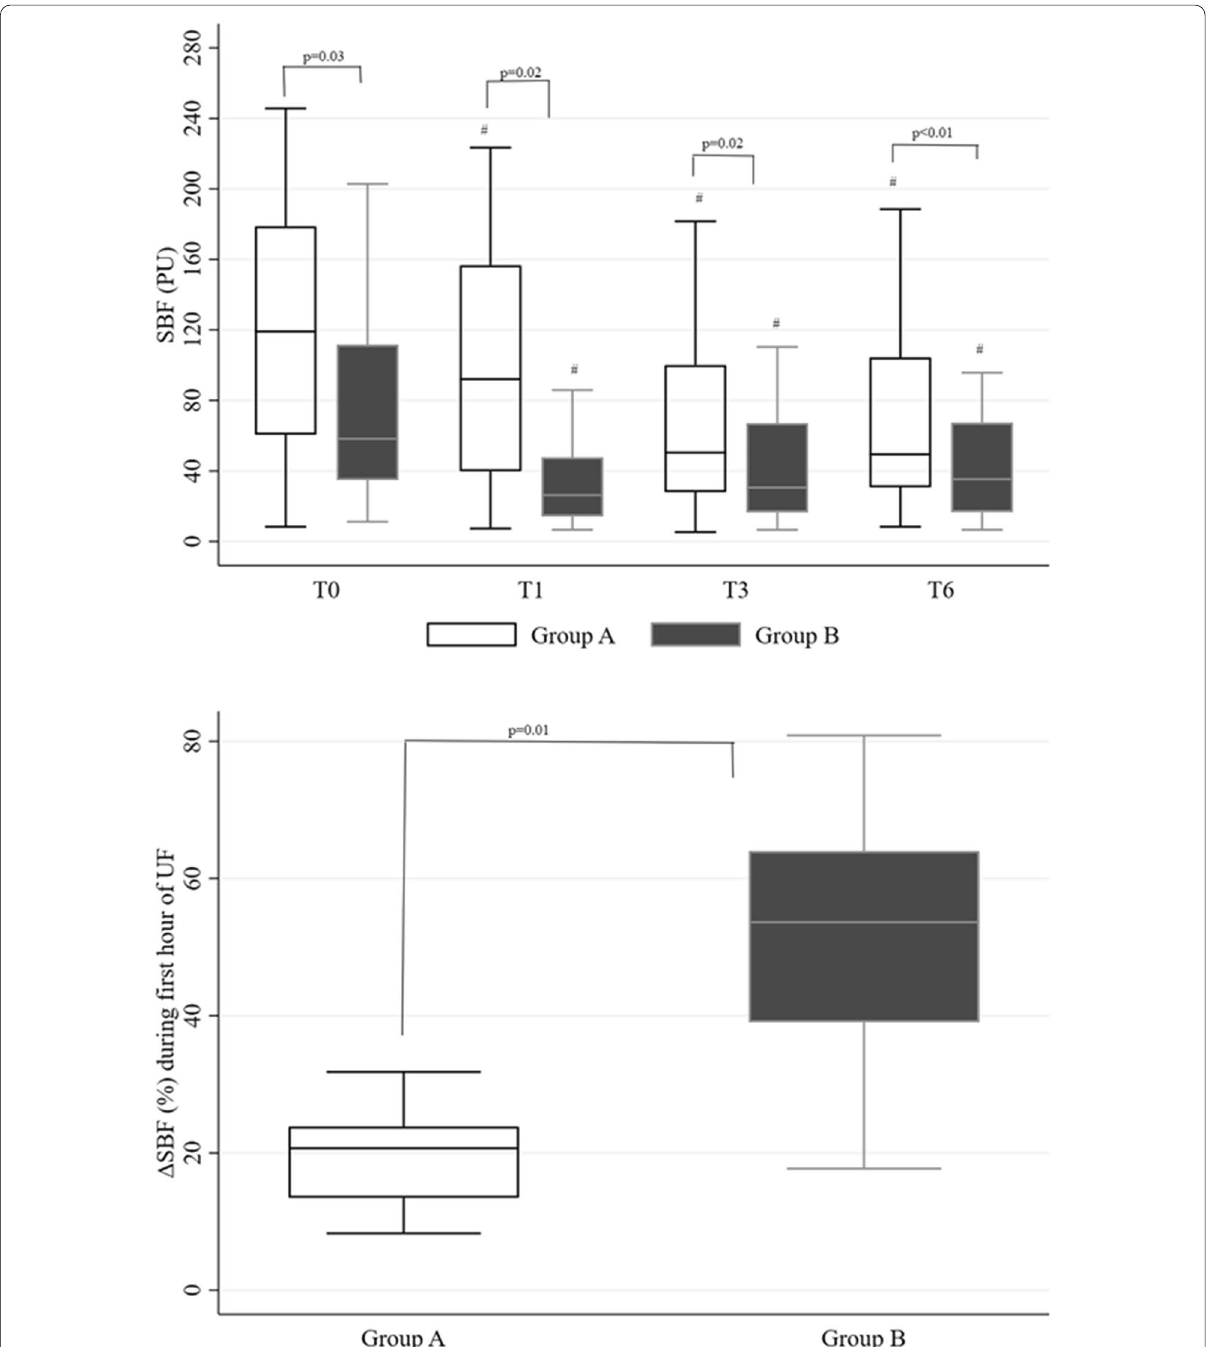
Fig. 1 Box‑and‑whisker plots (median and interquartile range) of skin blood flow (SBF) during fluid removal with CVVHDF ( a ) and change in SBF (∆SBF) during the first hour of fluid removal with CVVHDF (UF; b ) in the two groups. # p < 0.05 vs baseline (T0) in the same group; PU perfusion